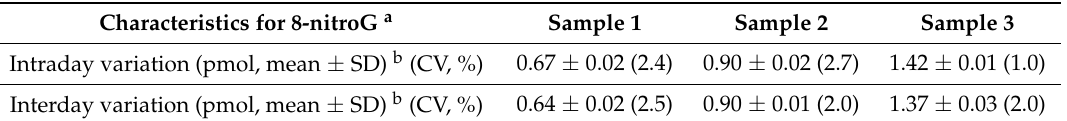
Table 1. Precision of isotope-dilution LC-MS/MS method with MTNG derivatization for analysis of 8-nitroG in